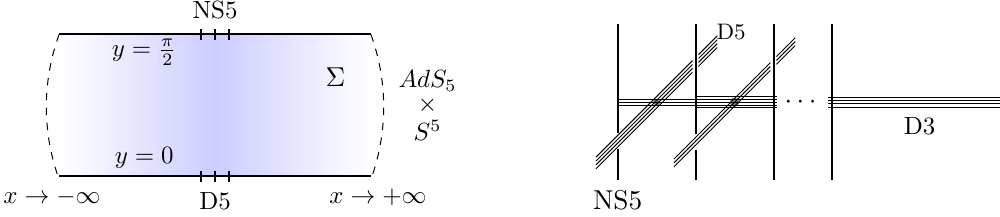
Figure 2 . Left: geometry of AdS 4 × S 2 × S 2 × Σ solutions with Σ = { x + iy ∈ C | 0 ≤ y ≤ π } 2 for non-gravitating baths. On each boundary component an S 2 collapses, so the 10d geometry is closed. D5/NS5 brane sources are located on the y = 0 / y = π boundaries. The limit x → −∞ is 2 a regular point of the internal space. For x → ∞ the solutions approach locally AdS 5 × S 5 ; this region corresponds to the conformal boundary in figure 1(a). The ETW brane in figure 1(a) can be seen as effective description for the remaining 10d geometry. Right: associated configuration of D5, NS5 and D3 branes, with D3-branes suspended between 5-branes and semi-infinite